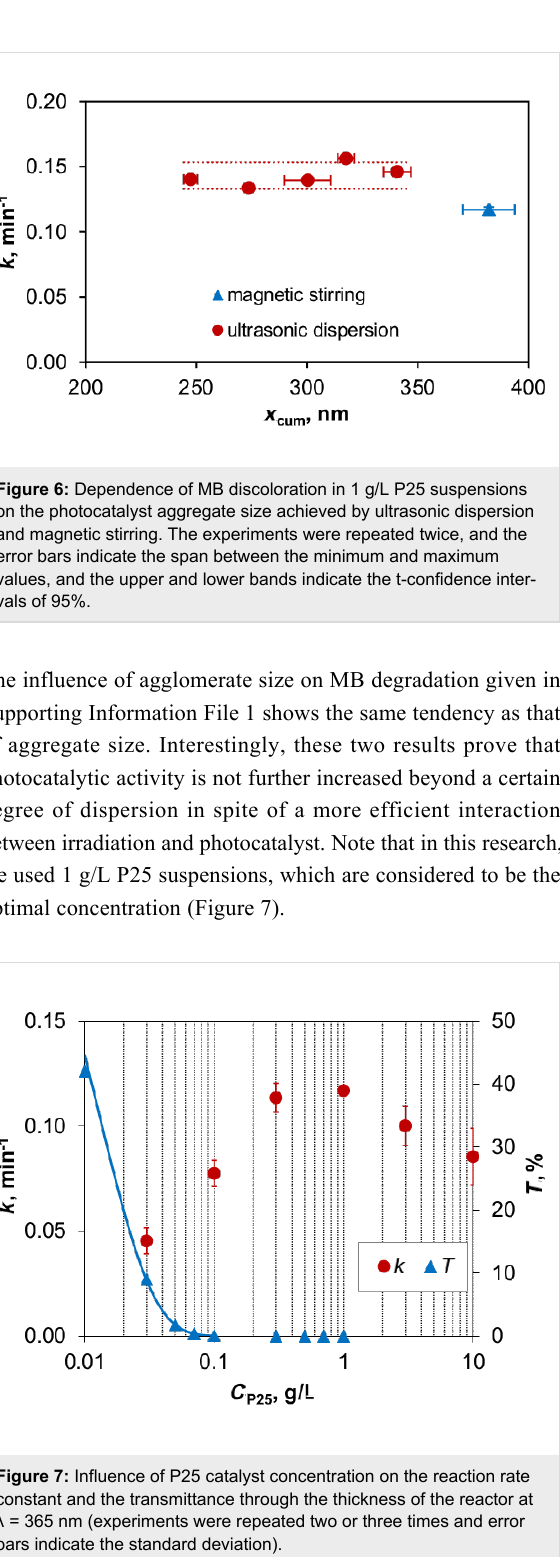
In the range of low concentration, the higher photocatalyst loading produces an increase of the active sites resulting in a faster degradation. A further increase in the concentration